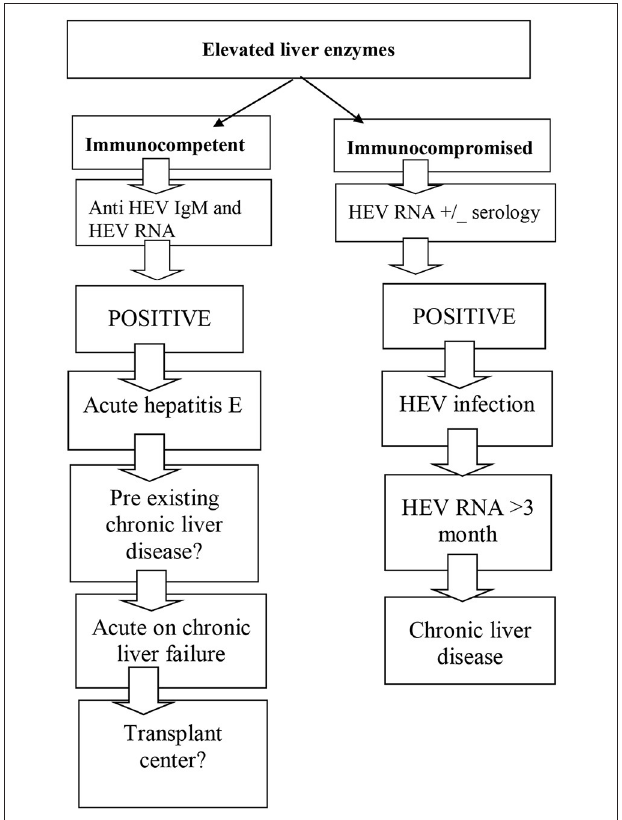
FIGURE 1 | Diagnostic algorithm for HEV infection.